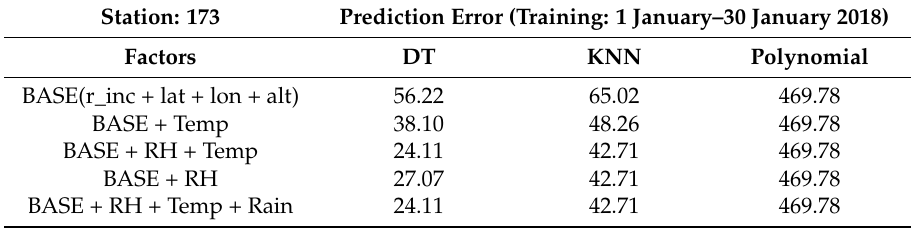
Table 11. Task 4: missing data prediction error of the sensor attribute r_inc from monitoring station 173 using decision trees, KNN, and polynomial machine learning methods on IoT Sensors dataset.